Question: Give a one-sentence summary of this figure.
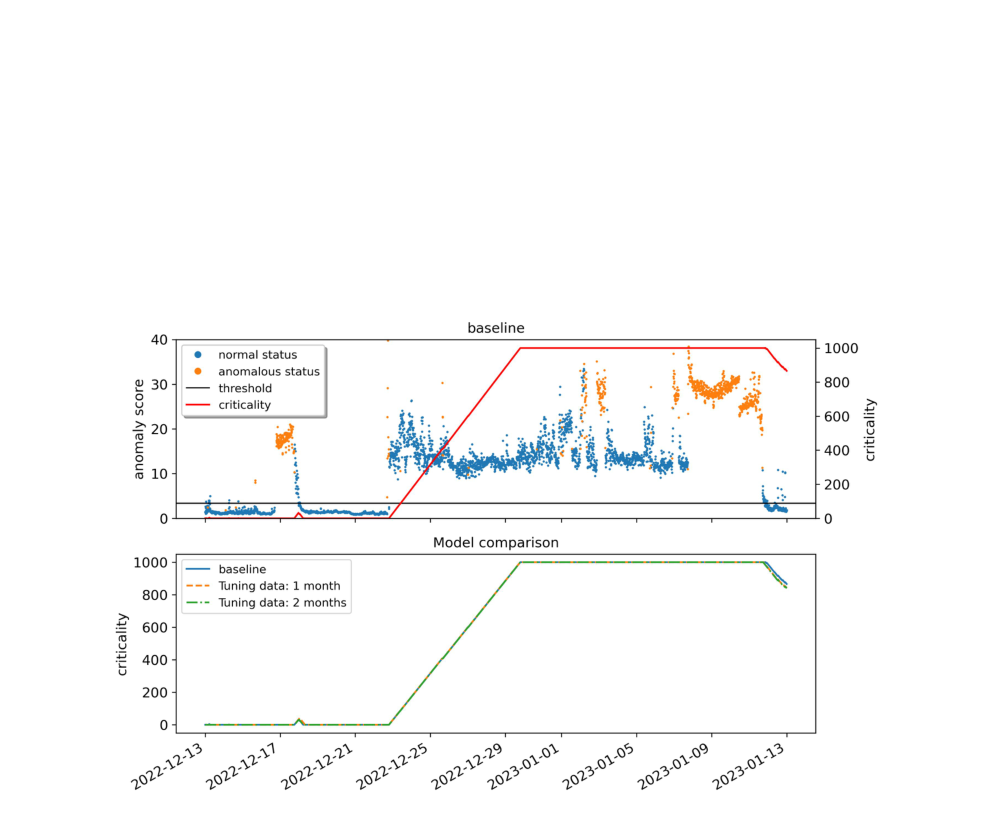
Answer: Case Study 1: Rotor brake and hydraulic problems for a wind turbine of WF A cause a change point in some sensor measurements. The anomalous behaviour is detected correctly by TL models using only 1 to 2 months of data for fine-tuning. The upper graph depicts the anomaly score, threshold and resulting criticality measure for the baseline model, the lower graph compares the criticality for the three models.